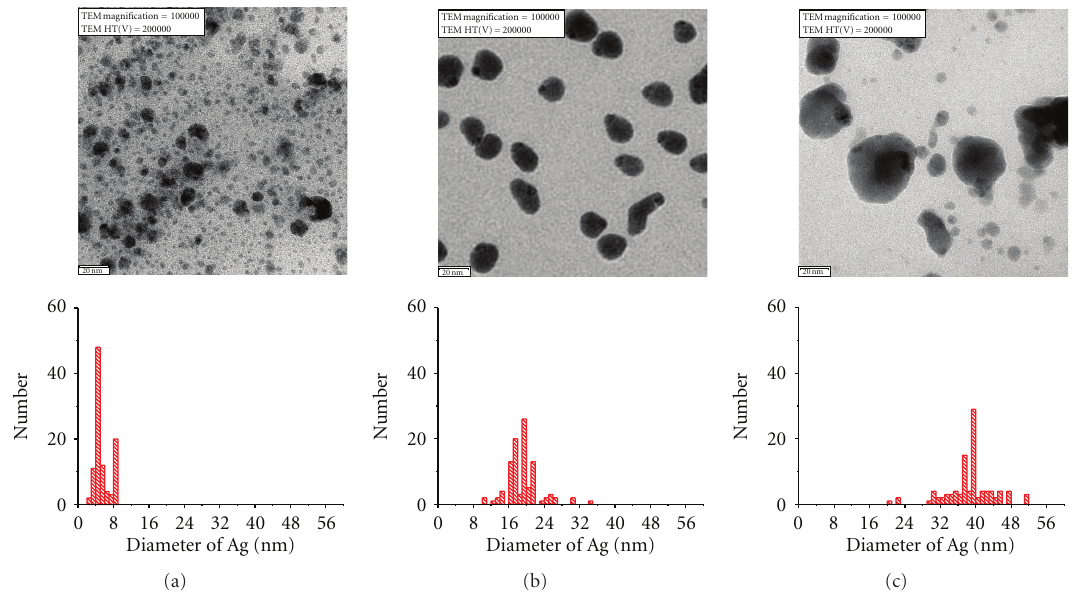
Figure 5: TEM micrographs and size distributions of silver nanoparticles prepared by photocatalytic reduction in a 0.1M AgNO 3 solution on the carbon-coated copper grids at UV exposure times of (a) 5 minutes, (b) 120 minutes, and (c) 240 minutes, respectively. The average size increases and the distribution broadens with an increase in the UV exposure time. (Note: graph plotted by OriginLab software program).